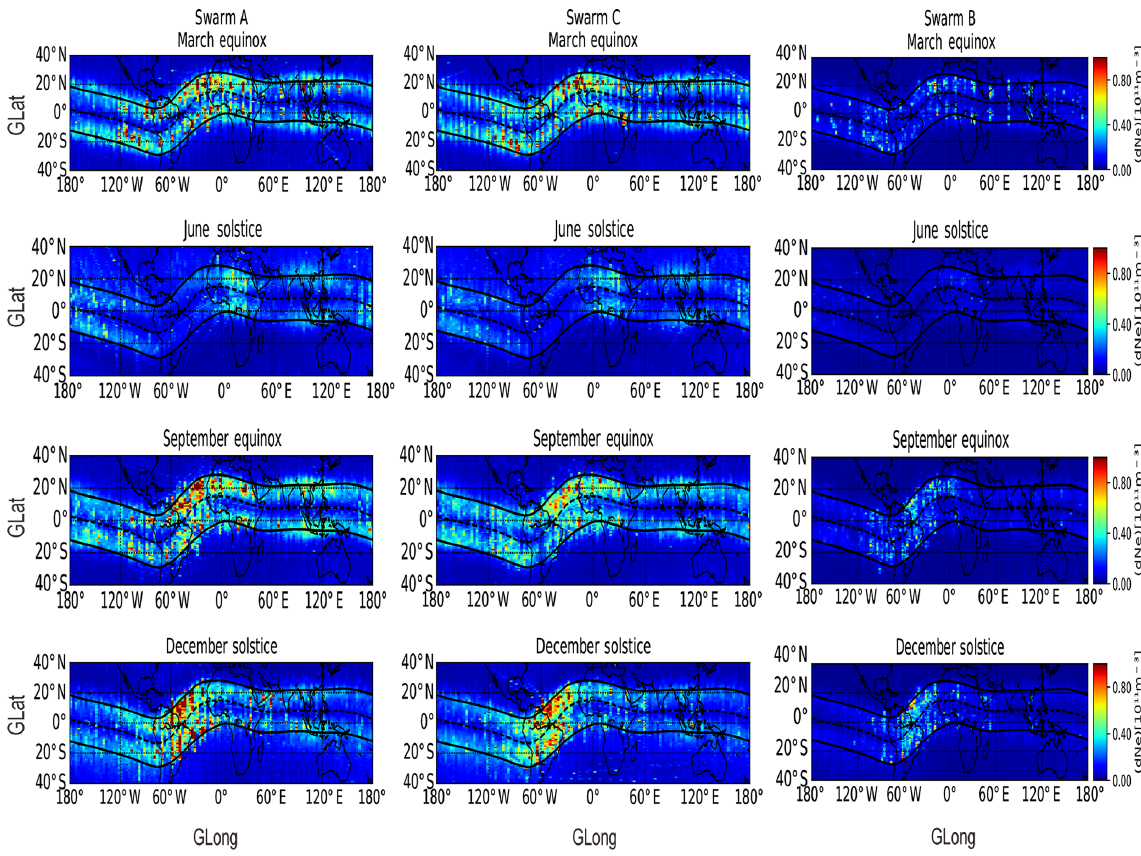
Figure 6. Absolute electron density perturbation ( dN e ) separated into four seasons (March or September equinox and June or December solstice) from October 2014 to October 2018 for Swarm A, C and B. The black dotted line represents the magnetic equator, while the black solid lines represent the EIA belts at about ± 15 ◦ of magnetic latitude. For each panel of a season, the colour scales represent dN e .